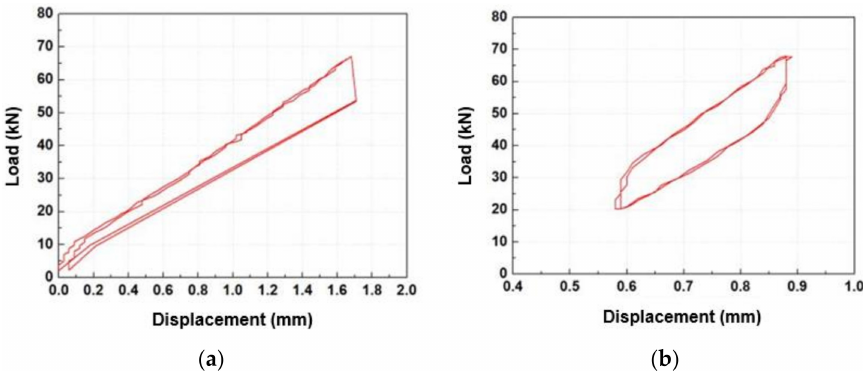
Figure 17. Measured results of static and dynamic loads (sample). ( a ) Static load; ( b ) Dynamic load.